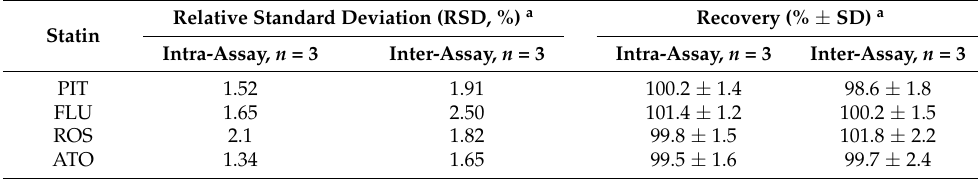
Table 4. Precision and accuracy of the proposed MW-SFA for determination of